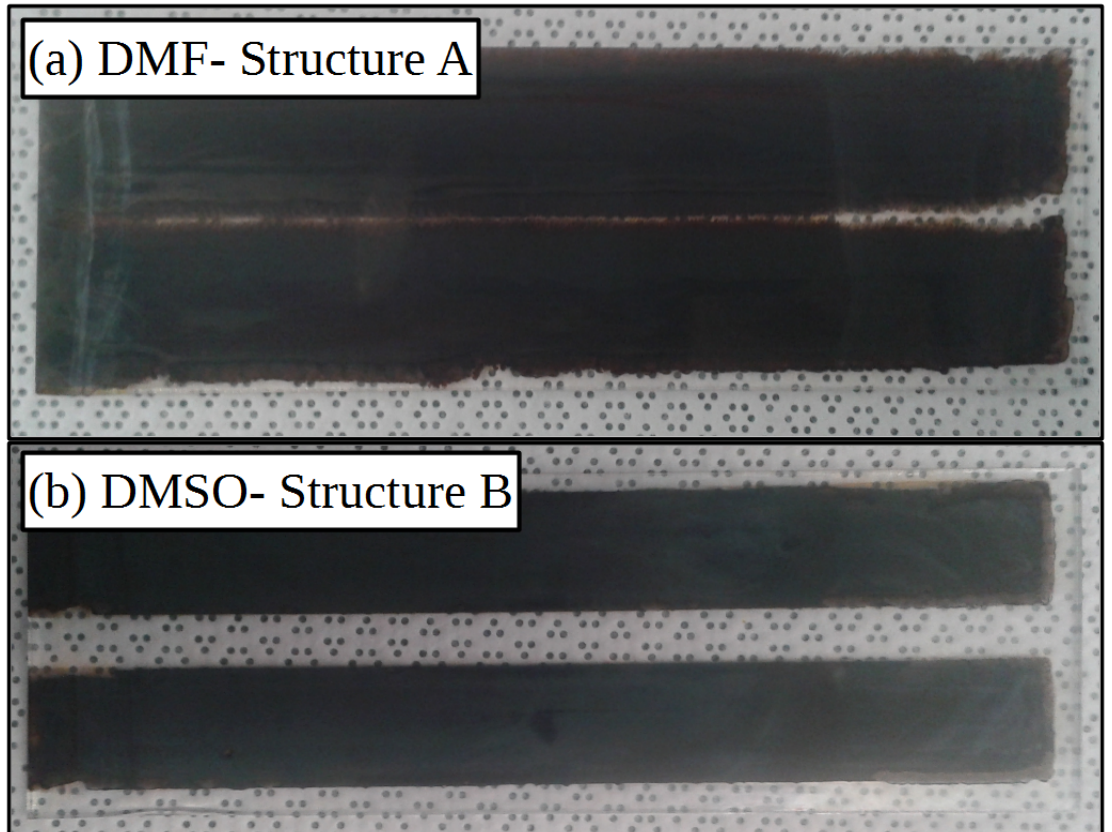
Figure 3. Pictures of perovskite films formed from coatings of lead iodide from either ( a ) DMF or ( b ) DMSO-based inks. Substrates are 15 cm by 5